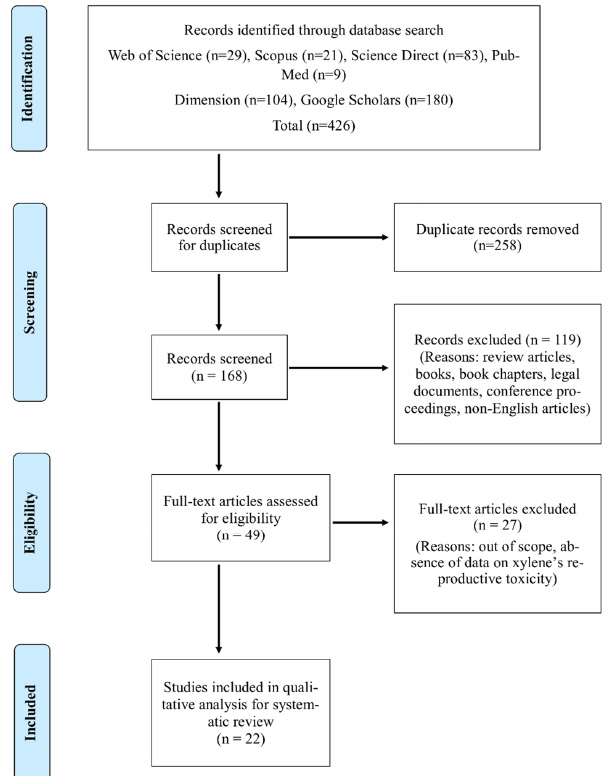
Figure 2. Article search and identification using PRISMA [14].